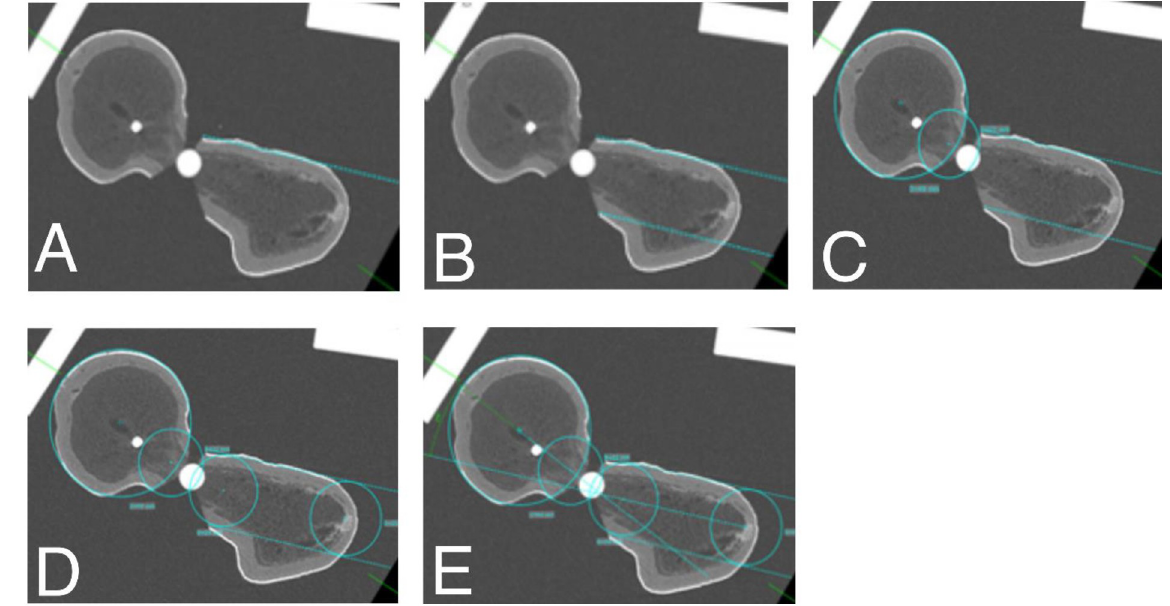
Fig 6. A axial plane with tangent to the ventral cortex of the greater trochanter. B axial section with parallel line to the tangent crossing the lesser trochanter. C axial plane with best-fitting circle in the femoral head and lateral head opening. D axial plane with best-fitting circles defining the lateral femoral neck. E transverse section showing the crossing point of both circles connecting